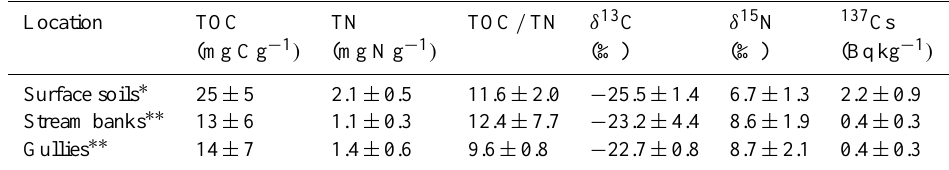
Table 2. Mean organic matter composition and 137 Cs activity ( ± 1 standard deviation) for surface soils ( n = 64), gullies ( n = 5) and stream bank ( n = 6) samples in the Houay Pano and Houay Xon catchments. For 137 Cs activity measurements, see Gourdin et al.